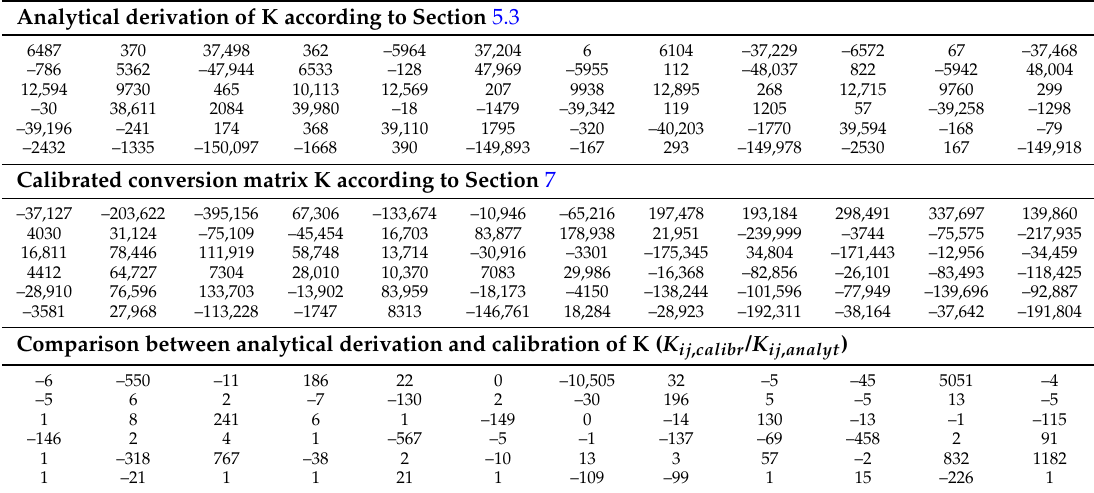
Table 2. Conversion matrices K determined according to Sections 5.3 and 7.